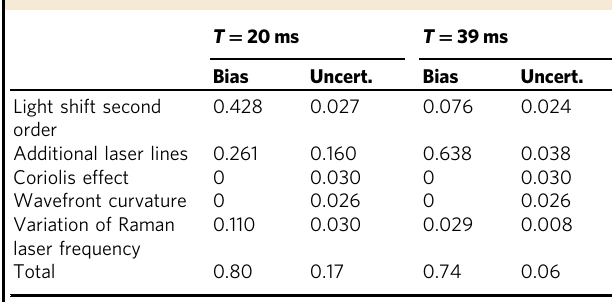
Table 2 Bias and uncertainties of the main systematic effects affecting the cold atom gravimeter for two different interrogation times